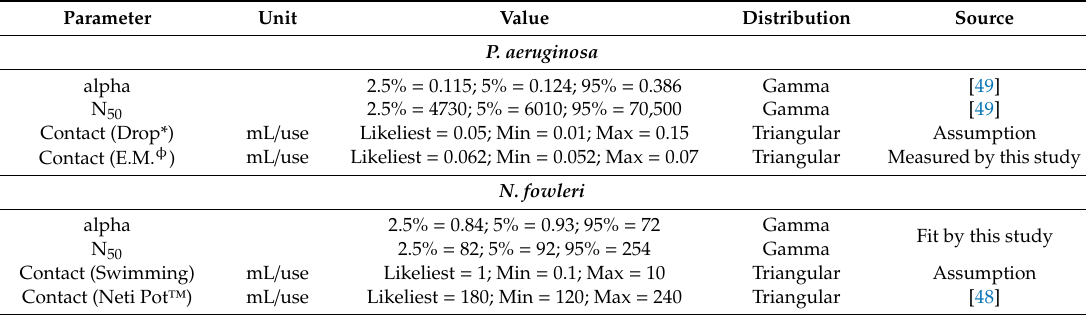
Table 3. Monte Carlo input parameters for P. aeruginosa and N.